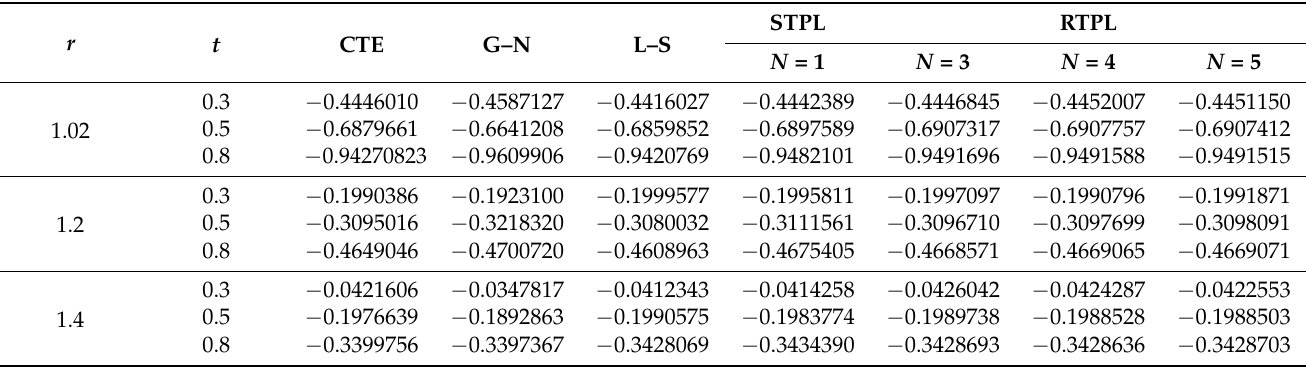
Table 2. Different thermoelasticity theories with a range of r values show the effects of dimensionless time t on radial displacement u .